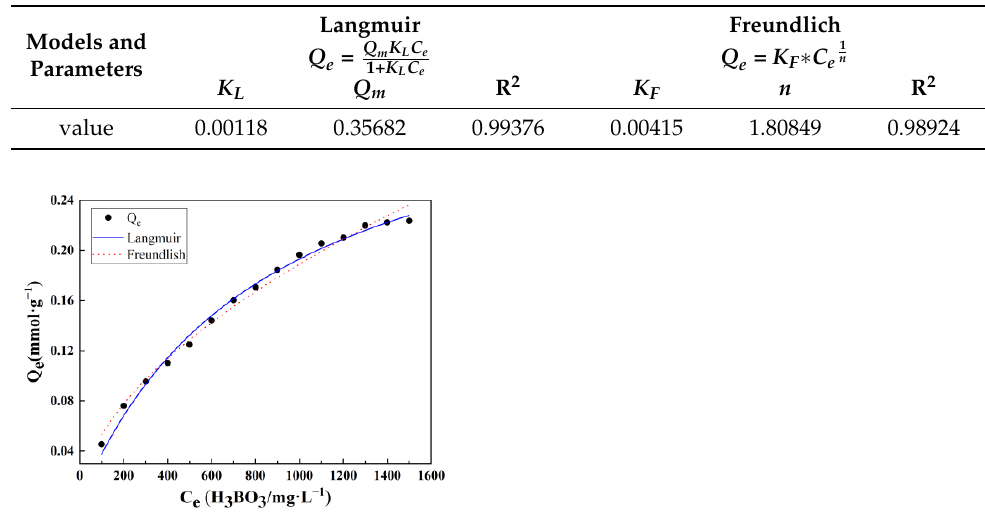
Figure 8. The comparison of the experimental values with the simulated values of Langmuir and Freundlich for the as-prepared PANI-OH-3 adsorbents.